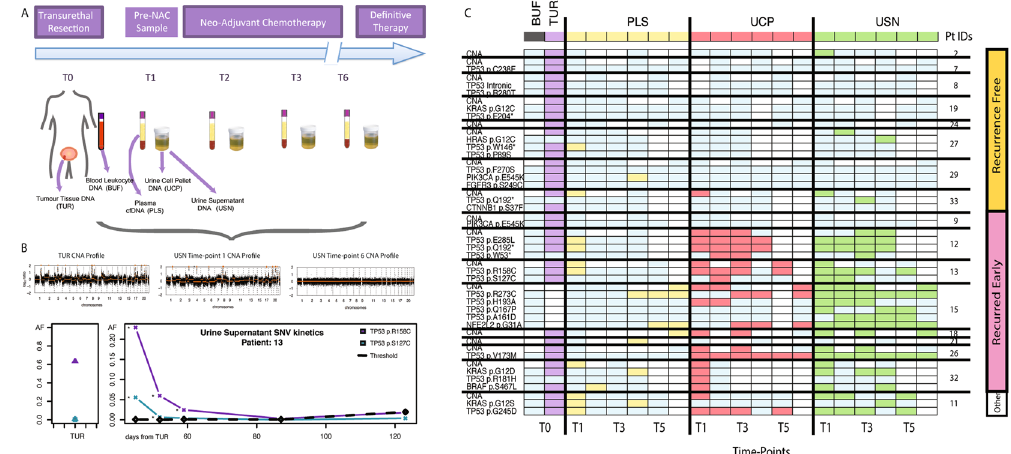
Figure 1. Analysis of Longitudinal mutDNA kinetics in MIBC. ( A ) Study design. 17 patients were enrolled at the NKI for mutDNA analysis whilst undergoing NAC. TUR was performed at the NKI or at regional institutions. PLS, UCP and USN were taken on one occasion before the initiation of NAC and subsequently on each chemotherapy visit, prior to definitive therapy. ( B ) Examples of longitudinal SNV and CNA analysis performed for each sample are shown. ( C ) Grid depicting mutDNA detection across all patients and time- points. The y-axis shows patients grouped by recurrence status, (right-side) and individual mutations (left- side). The x-axis shows sample-types (top) and time-points (bottom). Each cell of the grid indicates the result of a mutation analysis at that time-point (mutant-time-point analysis). White cells correspond to unavailable samples and light blue cells to samples where analysis did not detect mutDNA. Purple, yellow, red and green cells correspond to TUR, PLS, UCP and USN samples (respectively) where a mutDNA was detected. No mutations were detected in BUF (Grey). Raw AFs for the grid are provided in Supplementary Table 4.